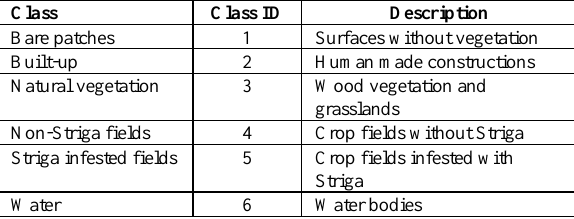
Water bodies Table 1: Landcover classes used in the classification analysis for both PlanetScope and Sentinel-2